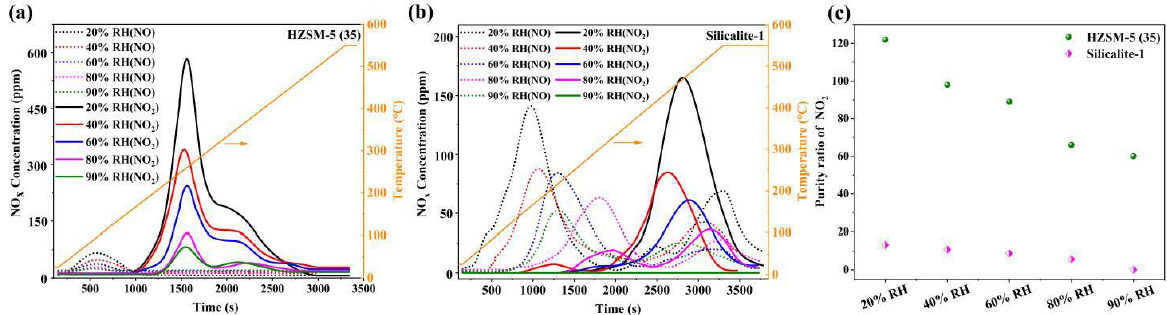
Figure 9. TPD curves of NO x under different RH conditions: ( a ) HZSM-5(35), ( b ) Silicalite-1 ( c ) purity ratio of NO 2 on HZSM-5(35) and Silicalite-1.